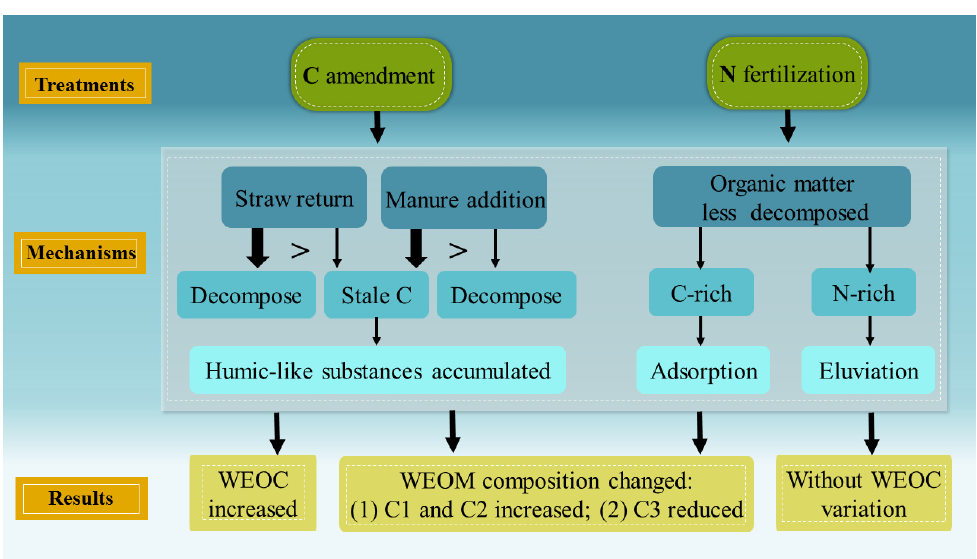
Figure 7. Schematic diagram showing the mechanisms by which carbon (C) amendment and nitrogen (N) fertilization practices quantitatively and qualitatively influence soil organic carbon and dissolved organic matter characteristics.